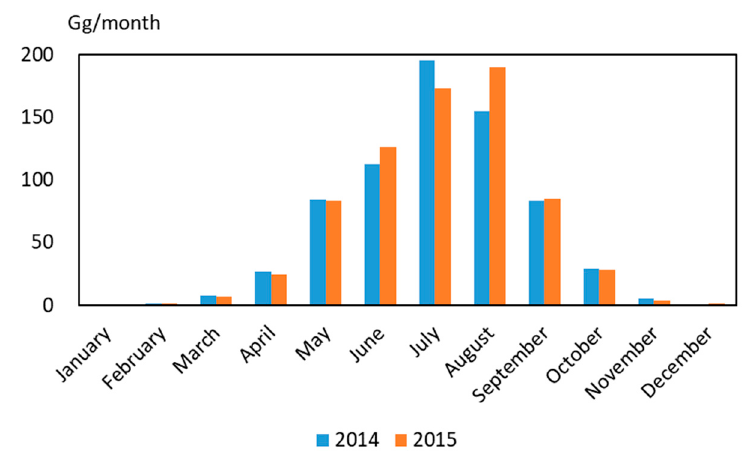
Figure 8. Modeling (bottom-up) isoprene emissions in South Korea (Case 4).